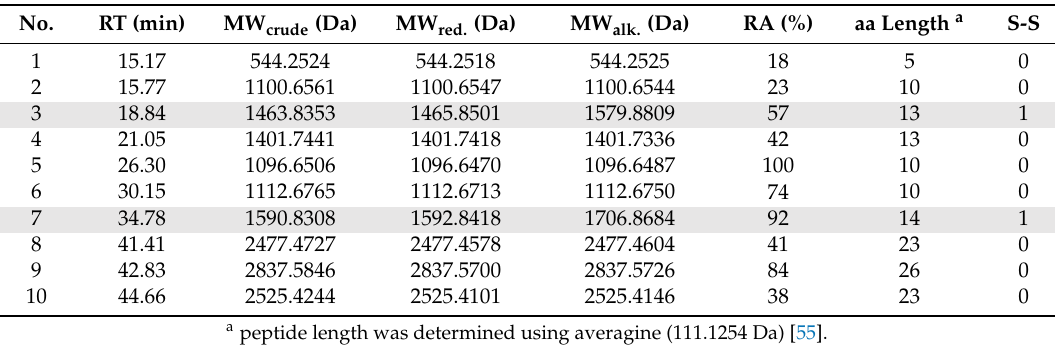
Table 1. Major peptides with a relative abundance >10% in the venom of the ruby ant M. rubra . Most of the peptides are linear, but reduction and alkylation of crude venom revealed the presence of two peptides with one intramolecular disulfide bond (highlighted in gray). RT: Retention time, MW: Molecular weight, RA: Relative abundance, aa: Amino acid, S-S: Disulfide bridges.